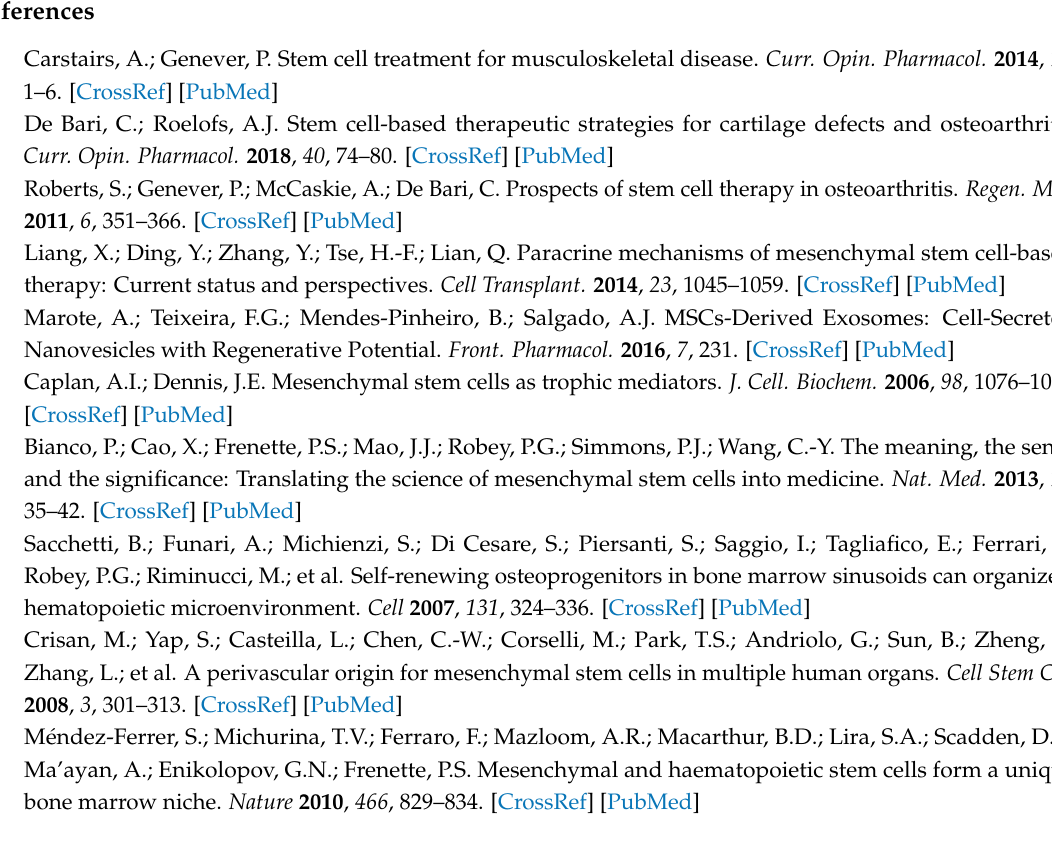
Figure S1: Development of an optimal 3D co-culture model using MSCs and ECs at different cell ratios; Figure S2: Whole MSC-EC spheroid images rendered using Volocity software. Figure S3: Early osteogenic and chondrogenic differentiation of MSCs prior to incorporation into spheroids. Table S1: Information on inhibitors used in MSC-EC spheroid experiments; Movie S1: Time-lapse brightfield microscopy of MSC:EC (50:50) spheroid formation over the first 17 h of culture, images taken every 15